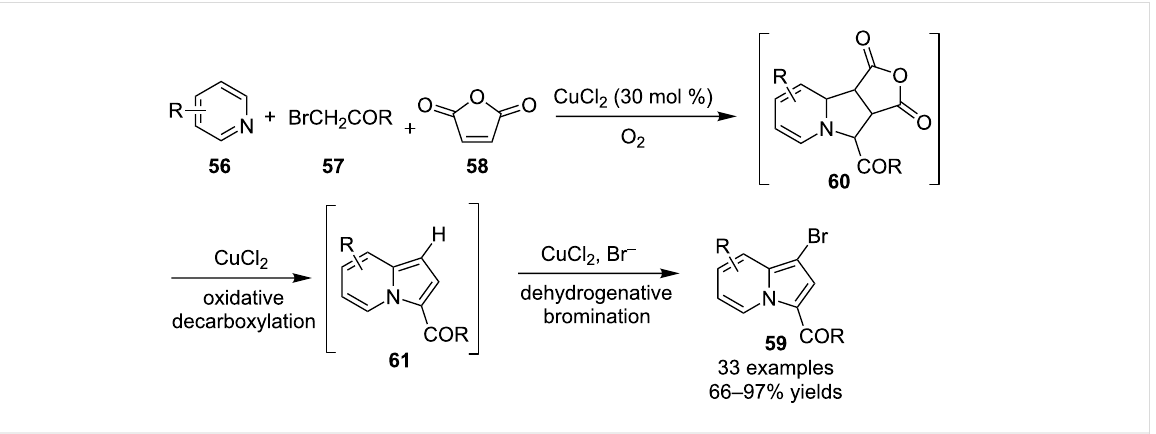
Scheme 19: Copper-catalyzed three-component synthesis of